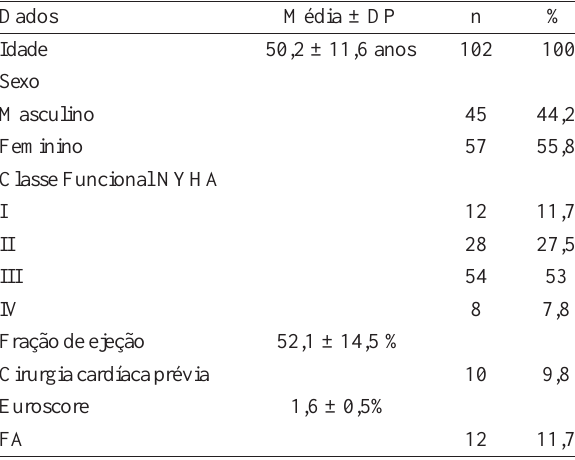
Tabela 1. Dados clínicos